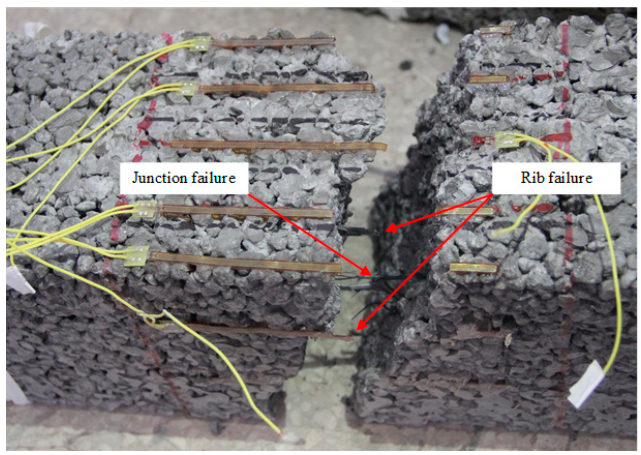
Figure 12. The failure model of geogrid in the bending test.